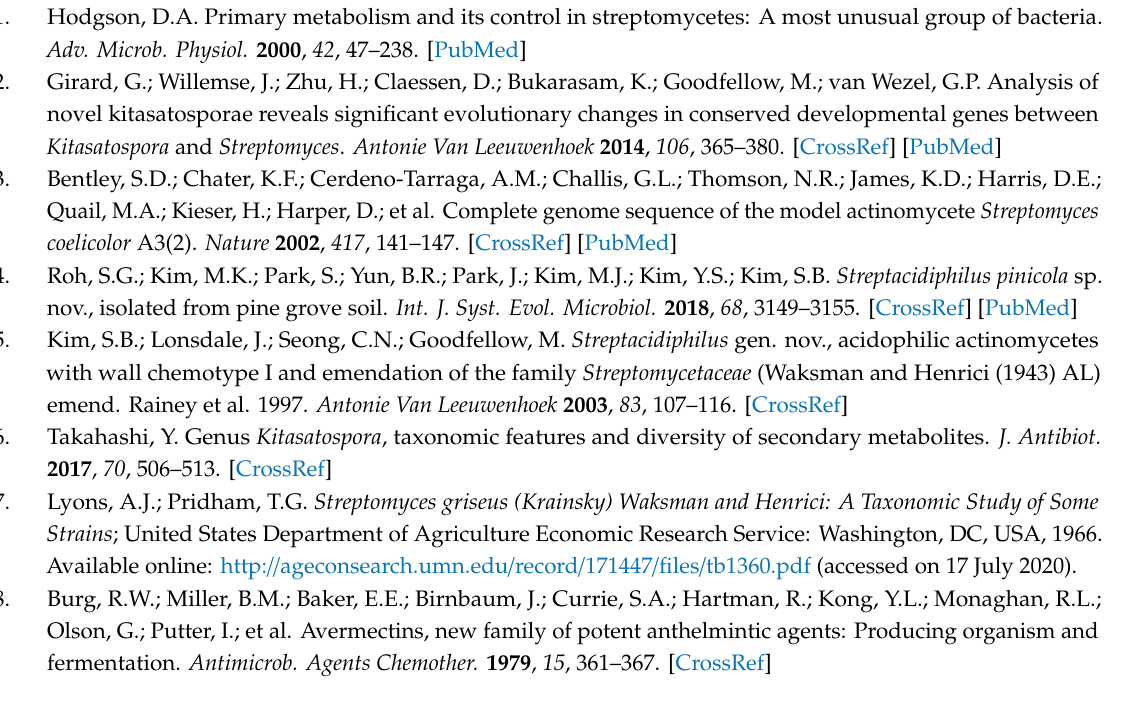
Table S2. Pan-genome of Streptacidiphilus mapped to KEGG pathways. (A) Core genes. (B) Accessory genes. (C) Unique genes. Table S3. Diversity of core structures predicted by antiSMASH in Streptacidiphilus. Structures from BGCs which consisted of 5 or more genes are shown only. Table S4. Predicted core lanthipeptides detected by antiSMASH in Streptacidiphilus . (A) Class I lanthipeptides. (B) Class II